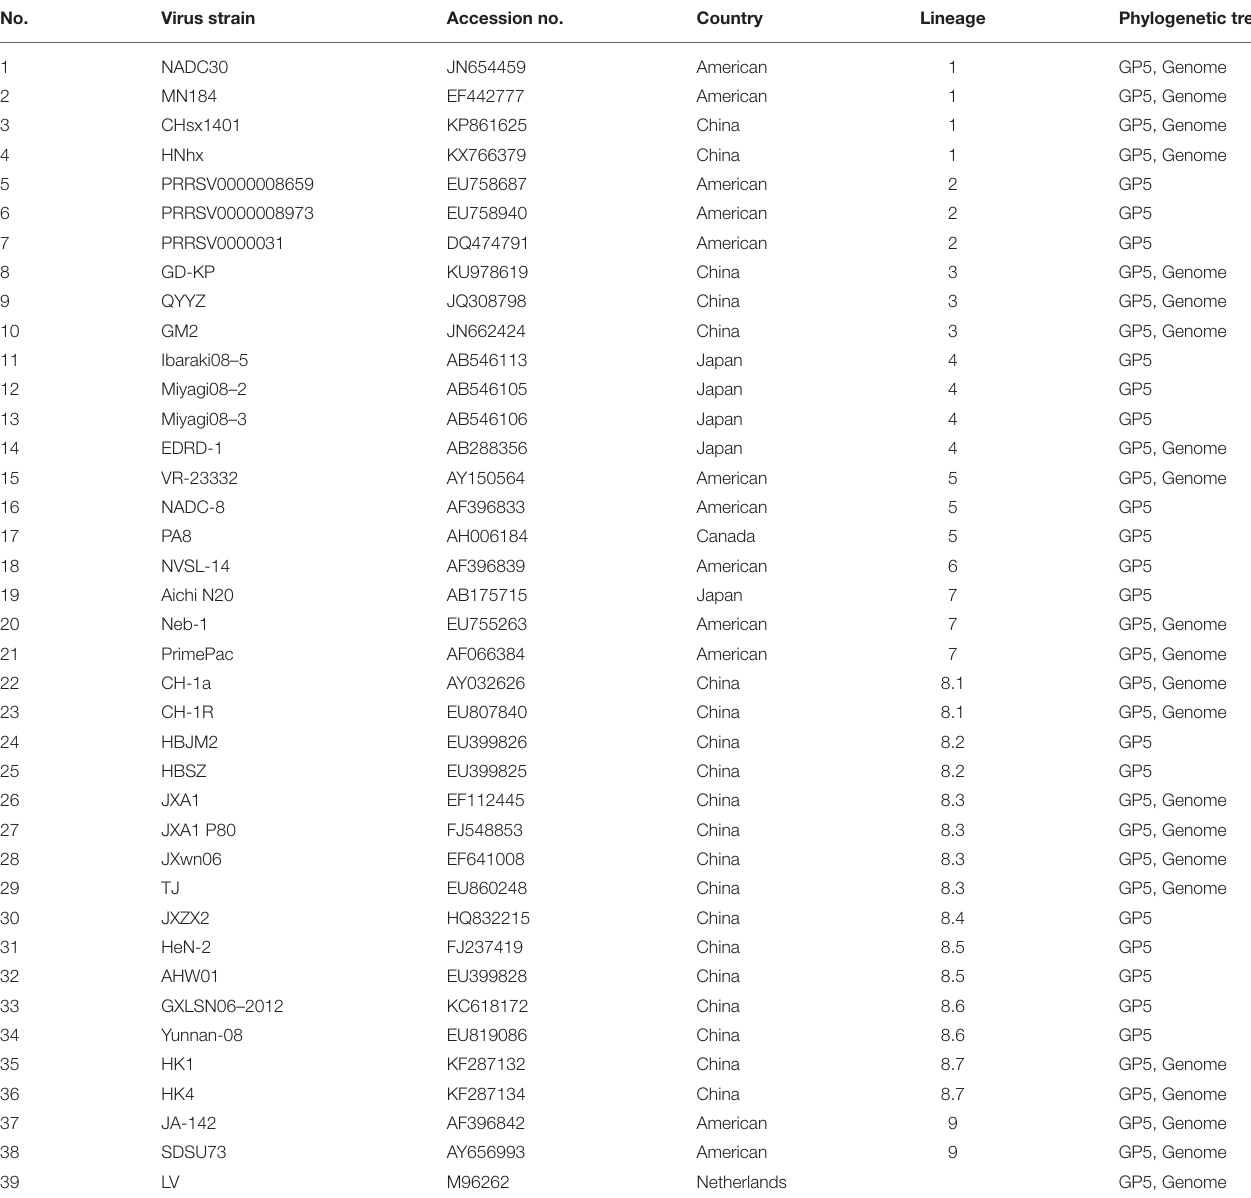
TABLE 1 | Information regarding the reference strains used in this